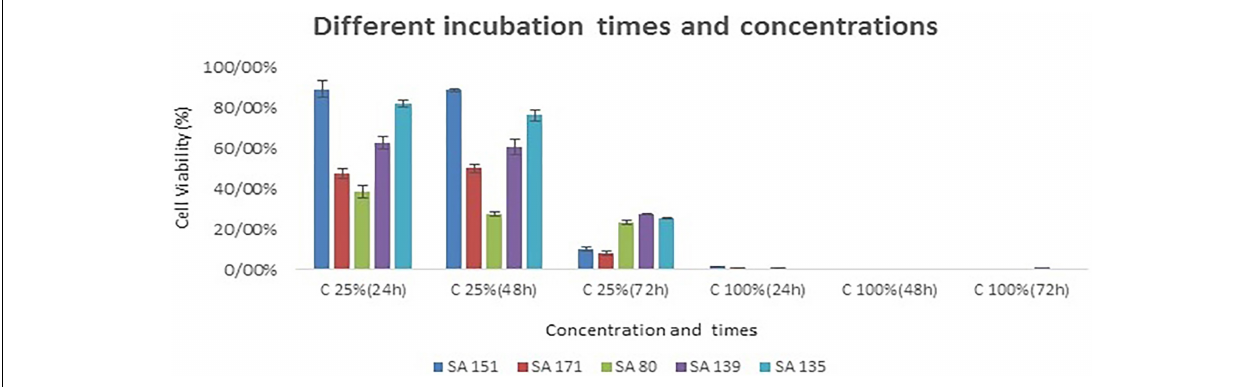
FIGURE 3 | The cytotoxic effects of bacterial culture free supernatants on the CaCo-2 cell line at different supernatant concentrations and incubation periods. The five probiotic candidates that were assessed included SA 151, SA 171, SA139 and SA 135.